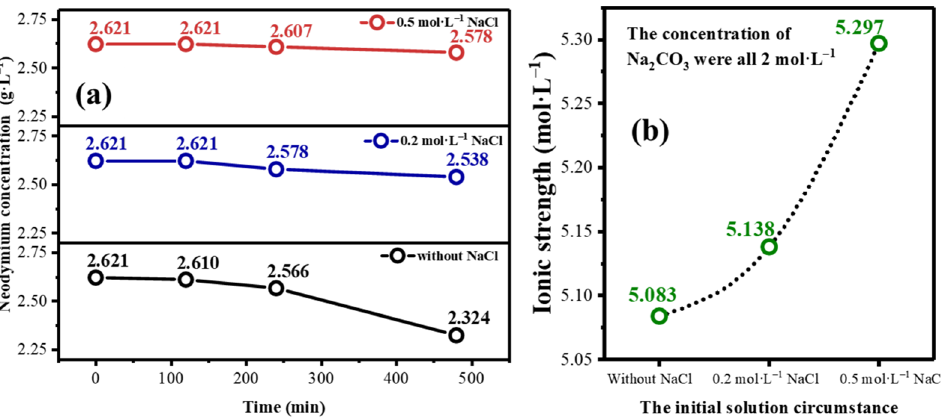
Figure 2. The effect of the concentration of the additional NaCl in ( a ) and Ionic strength of solution in ( b ).